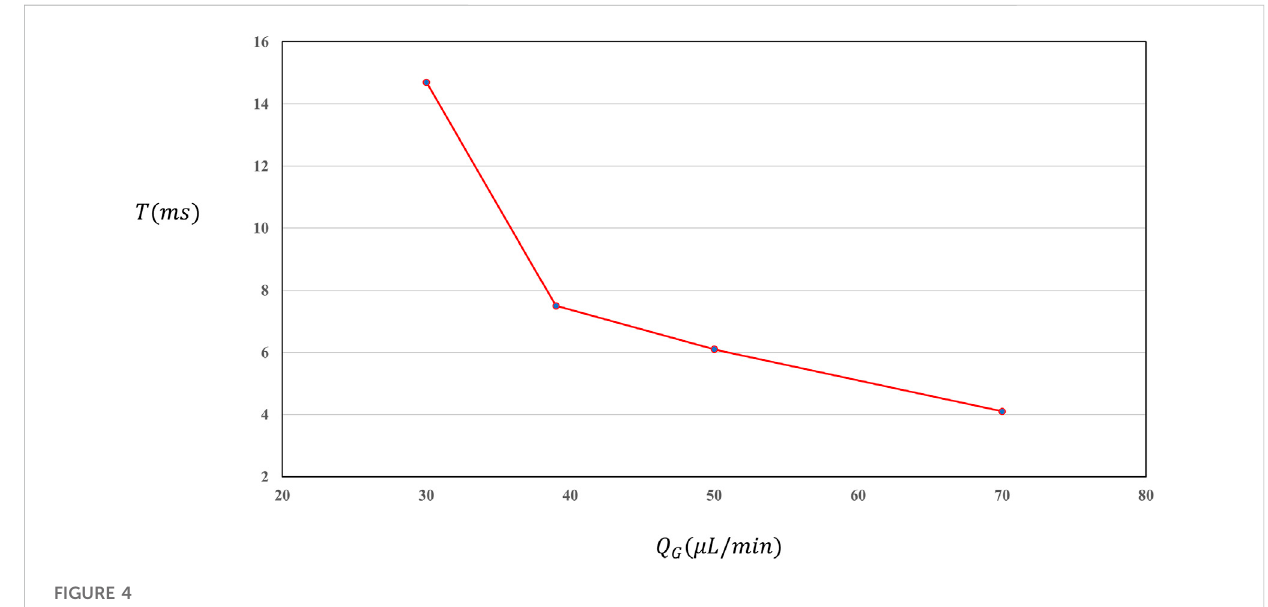
FIGURE 4 Generation cycle under different gas fl ow rate.